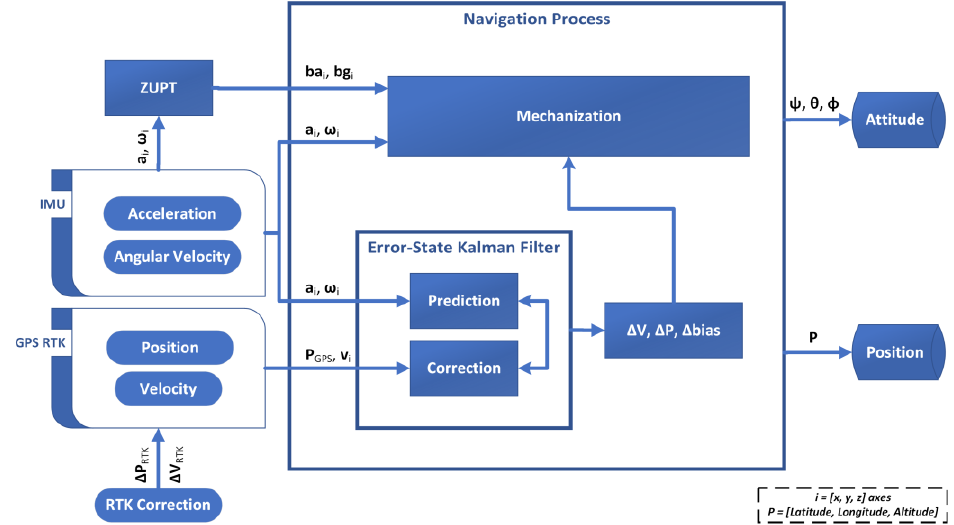
Figure 1. Block diagram of the proposed method based on GPS RTK/IMU integration for attitude and position monitoring.